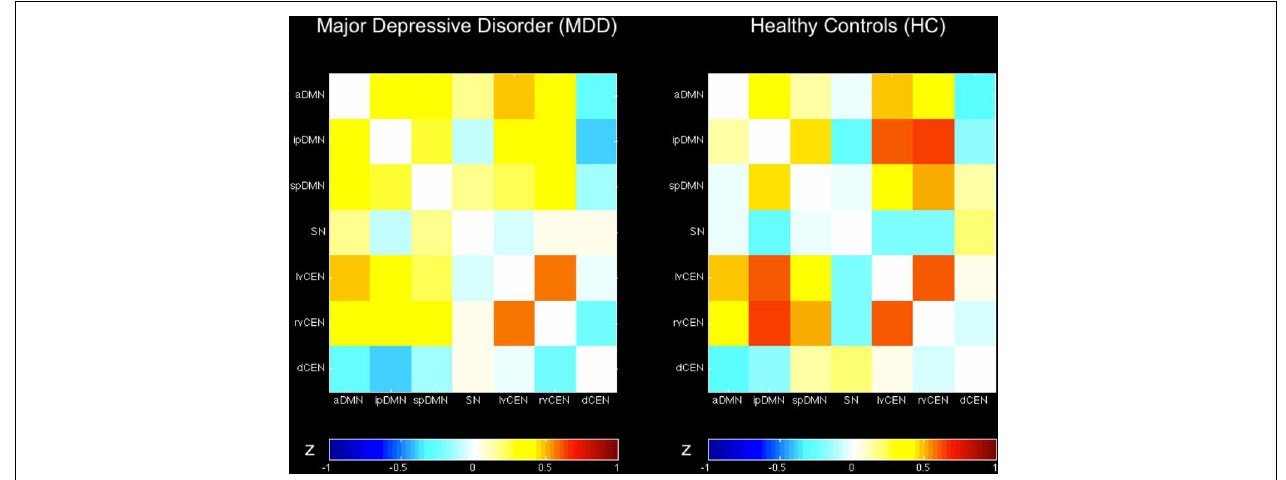
FIGURE 3 | Inter-network intrinsic functional connectivity matrix for patients with major depressive disorder and healthy controls. Pairwise Pearson’s correlations between time courses of selected ICs (derived from ICA of fMRI data) concerning the default mode, salience, and central executive network (DMN, SN, CEN) were Fisher-z-transformed, averaged